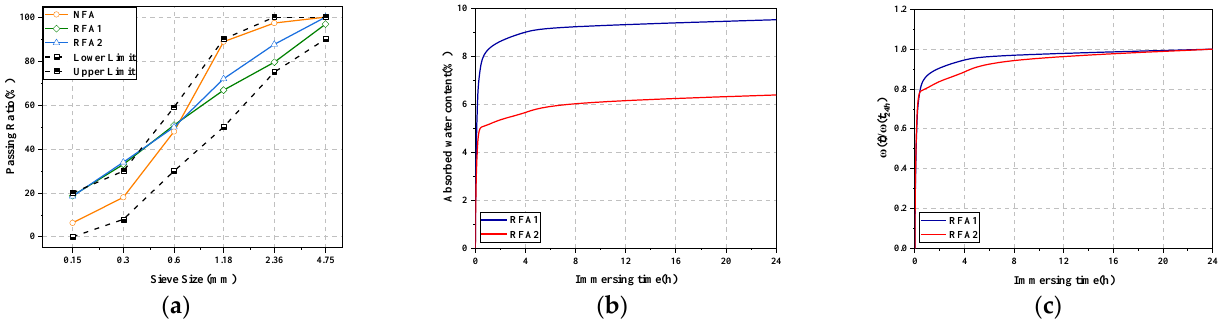
Figure 2. ( a ) Sieve size distribution of fine aggregates and ( b ) the variation of water content with time in RFA and ( c ) the variation trend of RFA water absorption after normalization treatment.